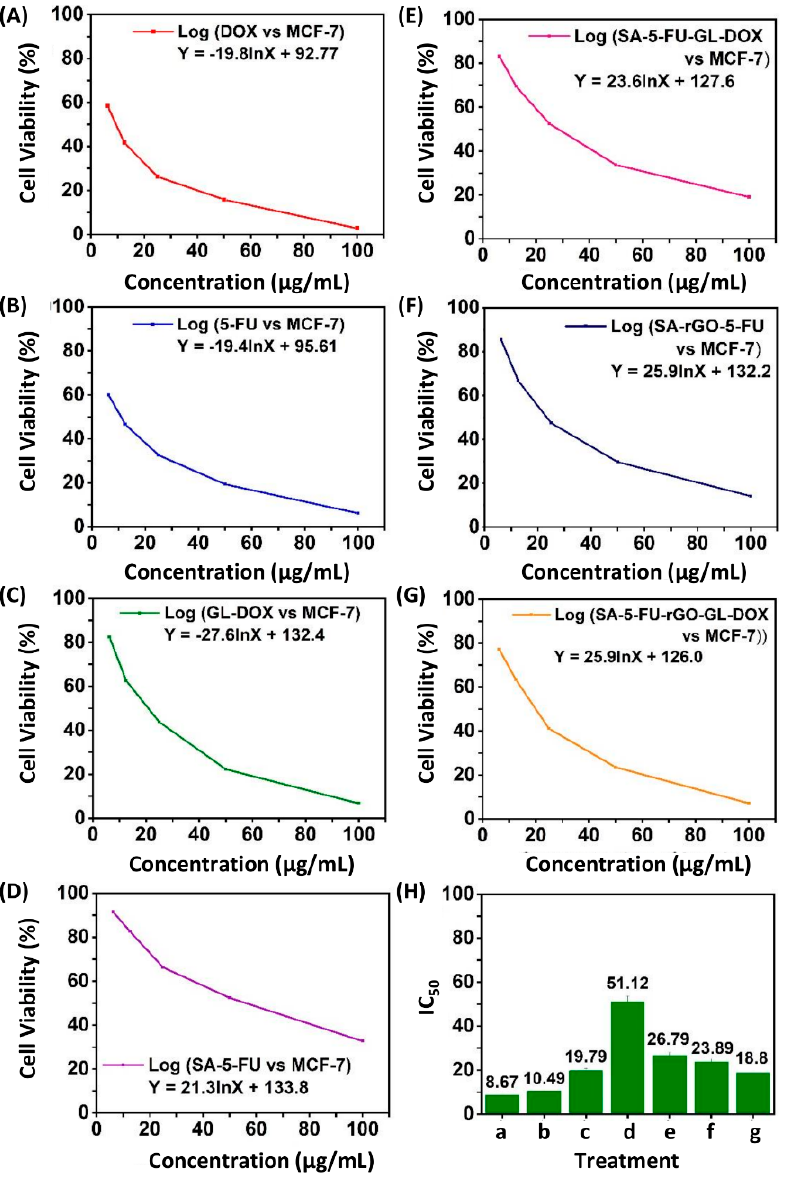
Figure 8. The viability of MCF-7 cells upon treatment with ( A ) DOX, ( B ) 5-FU, ( C ) GL-DOX, ( D ) SA-5-FU, ( E ) SA-5-FU- GL-DOX, ( F ) SA-rGO-5-FU and ( G ) SA-5-FU-rGO-GL-DOX. ( H ) The inhibitory concentration 50 (IC 50 ) values of (a) DOX, (b) 5-FU, (c) GL-DOX, (d) SA-5-FU, (e) SA-5-FU-GL-DOX, (f) SA-rGO-5-FU and (g) SA-5-FU-rGO-GL-DOX.